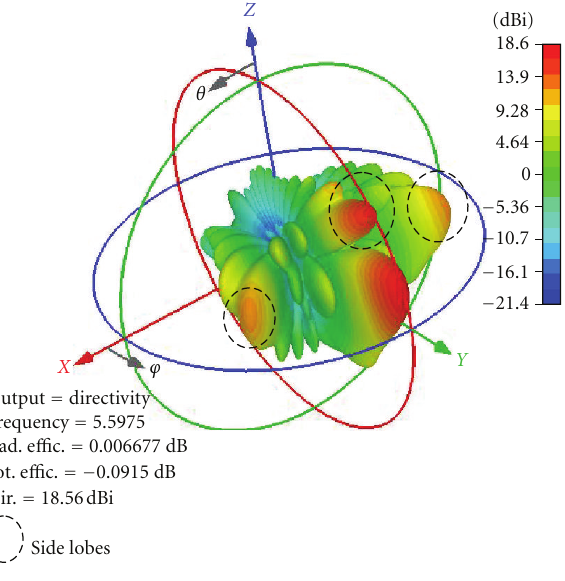
Figure 22: Simulated radiation pattern in 3D (directivity) of 4 × Yagi antenna at